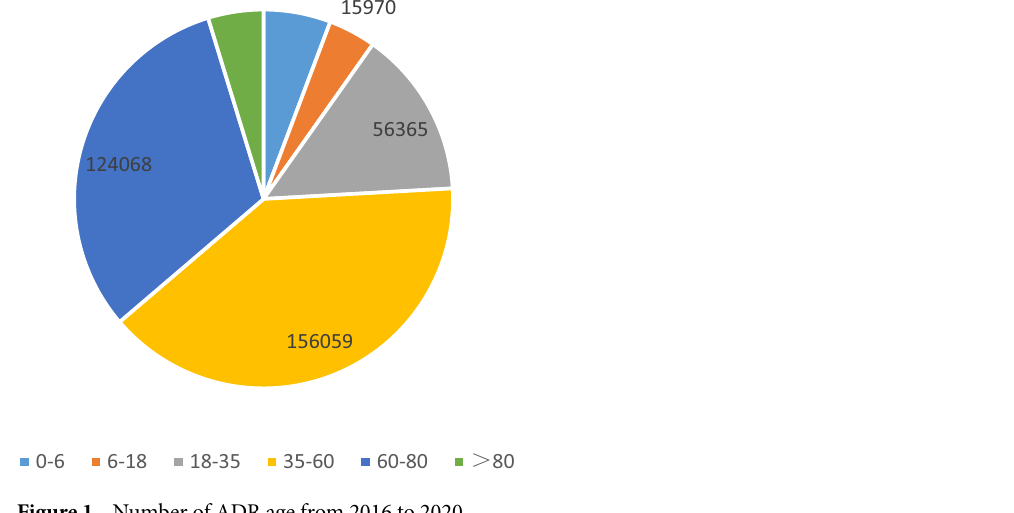
Figure 1. Number of ADR age from 2016 to 2020.